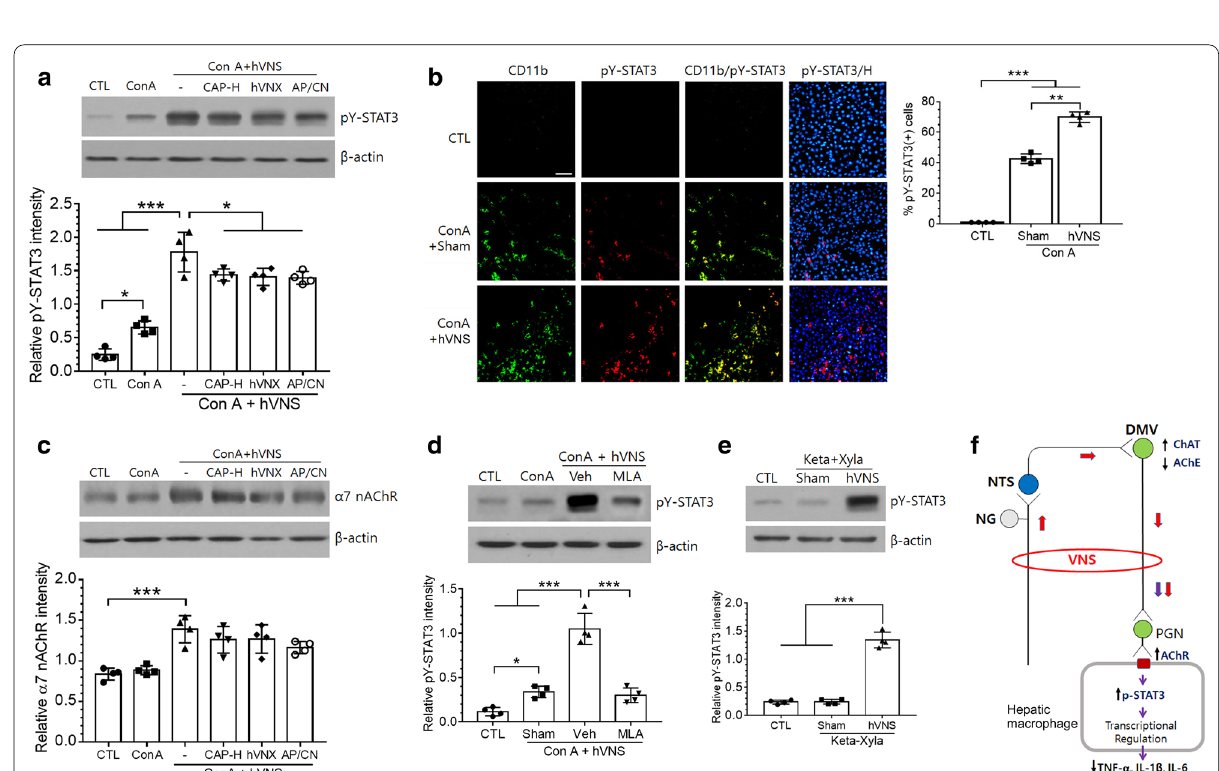
Fig. 9 Regulation on the production of α7 nAChRs and pY‑STAT3 in the liver by the inhibition of afferent vagus nerve activity in ConA‑injected animals. a Western blot analysis of liver tissue lysates from animal groups as indicated in the figure. A representative image from 4 independent experiments is shown (upper), and a quantification of pY‑STAT band intensity relative to actin is plotted (lower). Western blotting for actin as sample loading control. b Immunofluorescence localization of pY‑STAT3 and CD11b in the liver tissue. Perinuclear localization of pY‑STAT3 was identified by Hoechst nuclear staining (blue). A percentage of the number of pY‑STAT3‑immunostained cells relative to CD11b‑labeled cells was plotted (right). c , d Western blot analysis of α7 nAChRs ( c ) and pY‑STAT3 proteins ( d , e ) for protein lysates of liver tissue. Upper images are the representatives from 4 independent experiments. AP/CN; a group injected with AP‑5/CNQX into the DMV. Keta/Xyla; ketamine/xylazine. In a – e , one way ANOVA with Tukey post hoc is shown. *p < 0.05, **p < 0.01, ***p < 0.001. Scale bar in b 50 μm. f A schematic showing the proposed afferent vagus nerve = pathway activated by VNS that contributes to cholinergic anti‑inflammation in the liver. Afferent and efferent neve activity induced by VNS are shown by red and blue arrows respectively. NG; nodose ganglion, NTS; nucleus tractus solitarius, DMV; dorsal motor nucleus of the vagus nerve, PGN; postganglionic